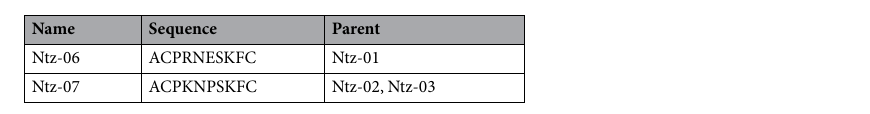
Table 3. Affinity matured peptide sequences. All peptides were synthesized with C-terminal GGG-Lys(biotin).